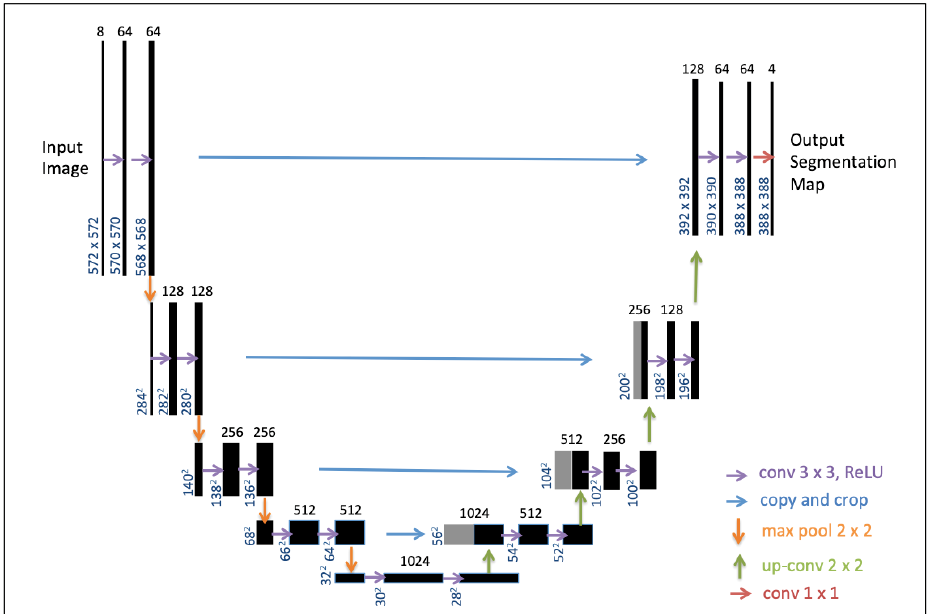
Figure 4. U-net architecture reproduced from [11]. The black boxes correspond to a multi-channel feature map. The number of channels is denoted on top of the box. The x-y-size is provided at the lower left edge of the box. Gray boxes represent copied feature maps. The colored arrows denote the separated operations. The final segmentation layer outputs 4 classes of labels for this study. Details refer to [11].